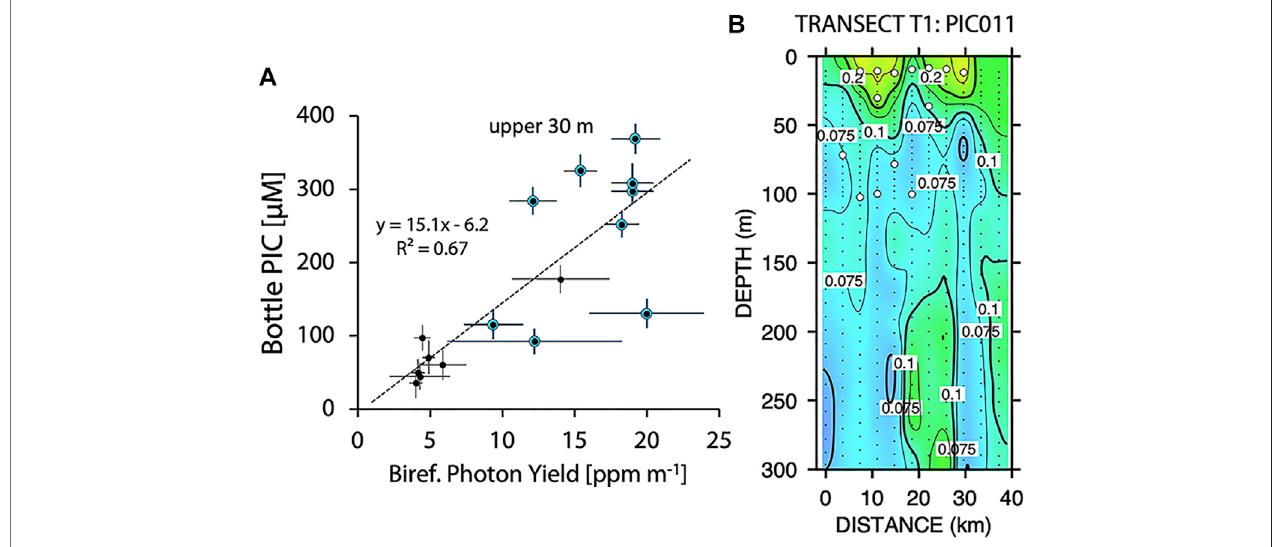
FIGURE 14 | (A) Regression of PIC measured in 1 L bottle samples versus birefringent photon yield for samples from Transect T1. Data from the upper 30 m are highlighted in the plot. The regression slope is 15.1. (B) Transect T1 sections for PIC and POC. Sample depths are shown as white circles on the PIC transect.